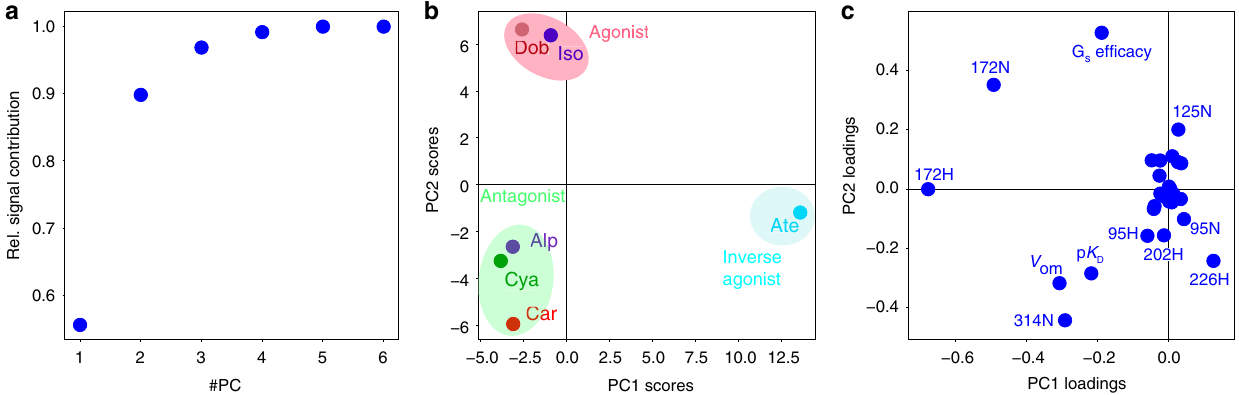
Fig. 4 PCA of chemical shift and biochemical data of YY- β 1 AR binary complexes. The PCA was carried out on a total of 186 chemical shifts and biochemical data of the YY- β 1 AR complexes with orthosteric ligands. For the isoprenaline complex, the chemical shifts of the major (preactive) conformation were used. a Relative contribution of the principal components to the total observed signal. b Scores plot of the fi rst two principal components (PC1 and PC2). Agonists, antagonists and inverse agonist cluster in different regions. c Loading plot of the fi rst two principal components. Source data are provided as a Source Data fi